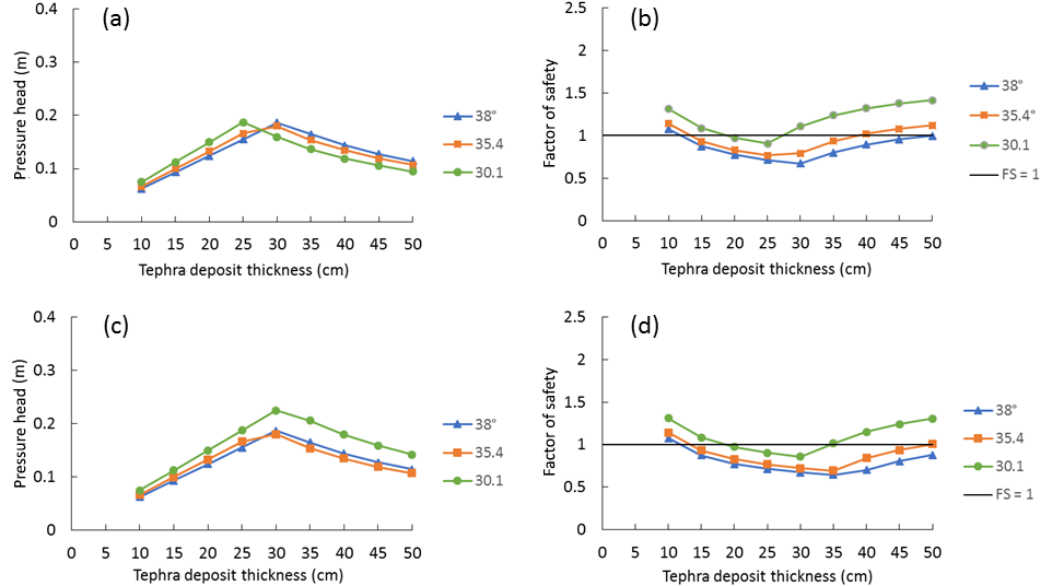
Figure 11. Total pressure head and factor of safety versus tephra fallout deposit thicknesses between 0.1 and 0.55m for Vulcanian tephra fallout deposits (Table 3) and a rainfall intensity of the following: (a, b) 6.4mmh − 1 with a duration of 5h ( I/K s = 0 . 02); (c, d) 15.5mmh − 1 with a duration of 3h ( I/K s = 0 . 05) (see also Table